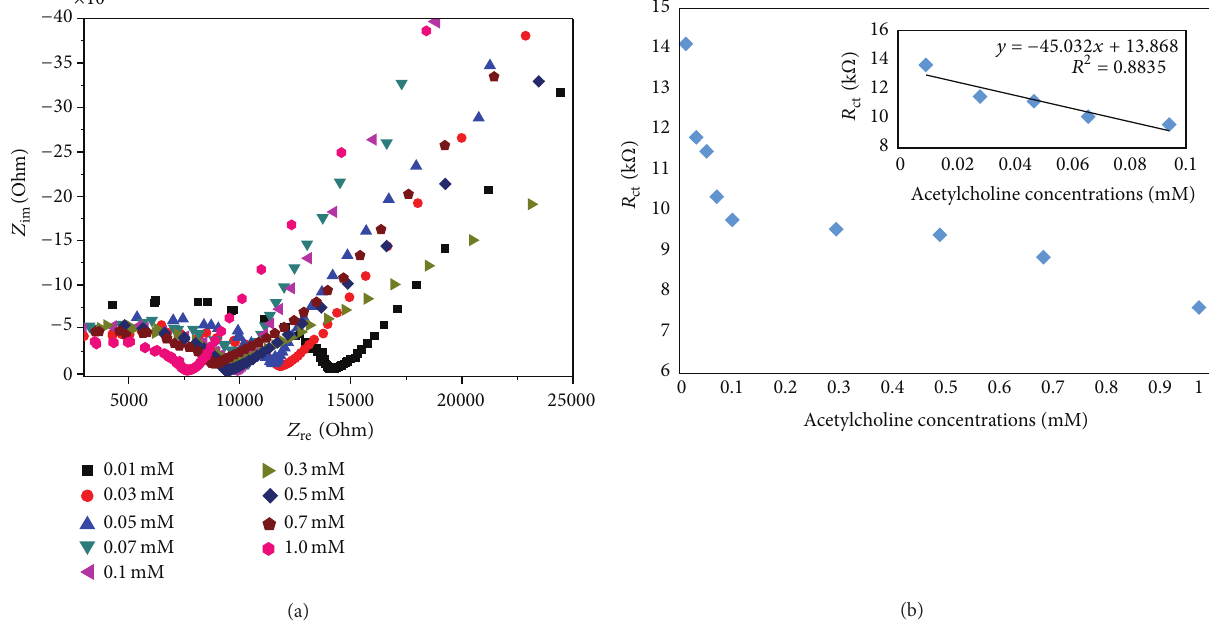
Figure 11: Electrochemical impedance spectra of the acetylcholine with the AChE-ChOx-modified biosensor based on a SPE in 0.1M PBS (pH = 7.0) containing 1.0 mM K 3 Fe(CN) 6 /K 4 Fe(CN) 6 and calibration curve.